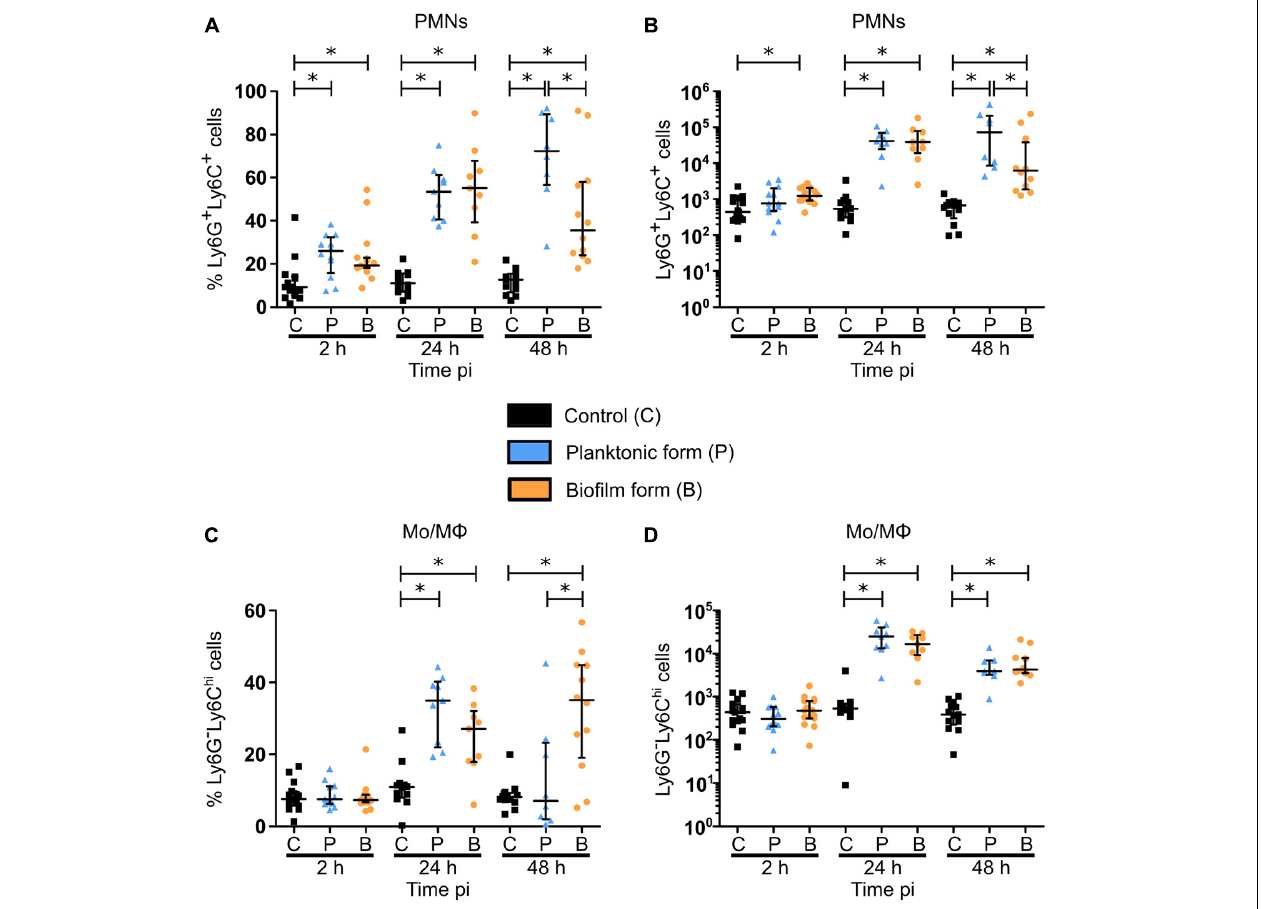
FIGURE 5 | Myeloid cell recruitment in the auricular draining lymph nodes of S. aureus infected mice. (A–D) Percentages (A,C) and total numbers (B,D) of PMNs (A,B) and MOs/M (cid:56) s (C,D) among myeloid cells in dLNs of control and planktonic or biofilm infected mice, from 2 h pi to day 2 pi (median ± IQR, number of mice: N C = 12–15, N P = 8–12, N BF = 9–15, from at least 3 different experiments, Mann-Whitney two-tailed test, ∗ p <